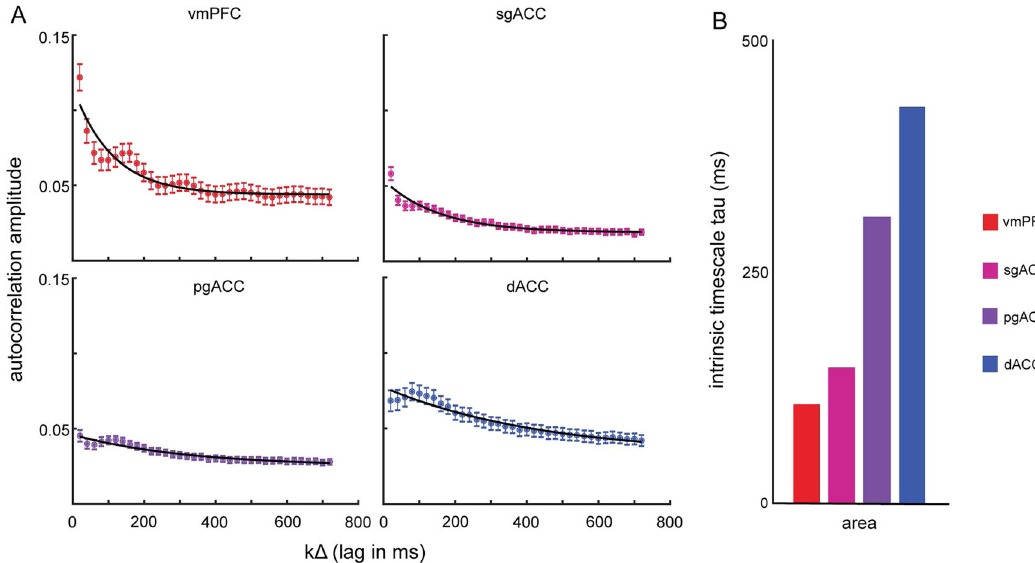
Fig. 5 Intrinsic timescales. A Spike-count autocorrelations calculated at increasing lags for each of the four brain areas (red = vmPFC: n = 156 neurons; pink = sgACC: n = 146 neurons; purple = pgACC: n = 213 neurons; blue = dACC: n = 129 neurons). The decay of autocorrelation amplitude with lag was fi tted by an exponential decay function with offset (black line). Error bars indicate the standard error for autocorrelation amplitude across neurons at a given lag. Source data are provided as a Source Data fi le. B A summary table of the intrinsic timescales, extracted from the exponential decay function. The fi gure demonstrates a smooth increase of intrinsic timescale along a gradient. Source data are provided as a Source Data fi